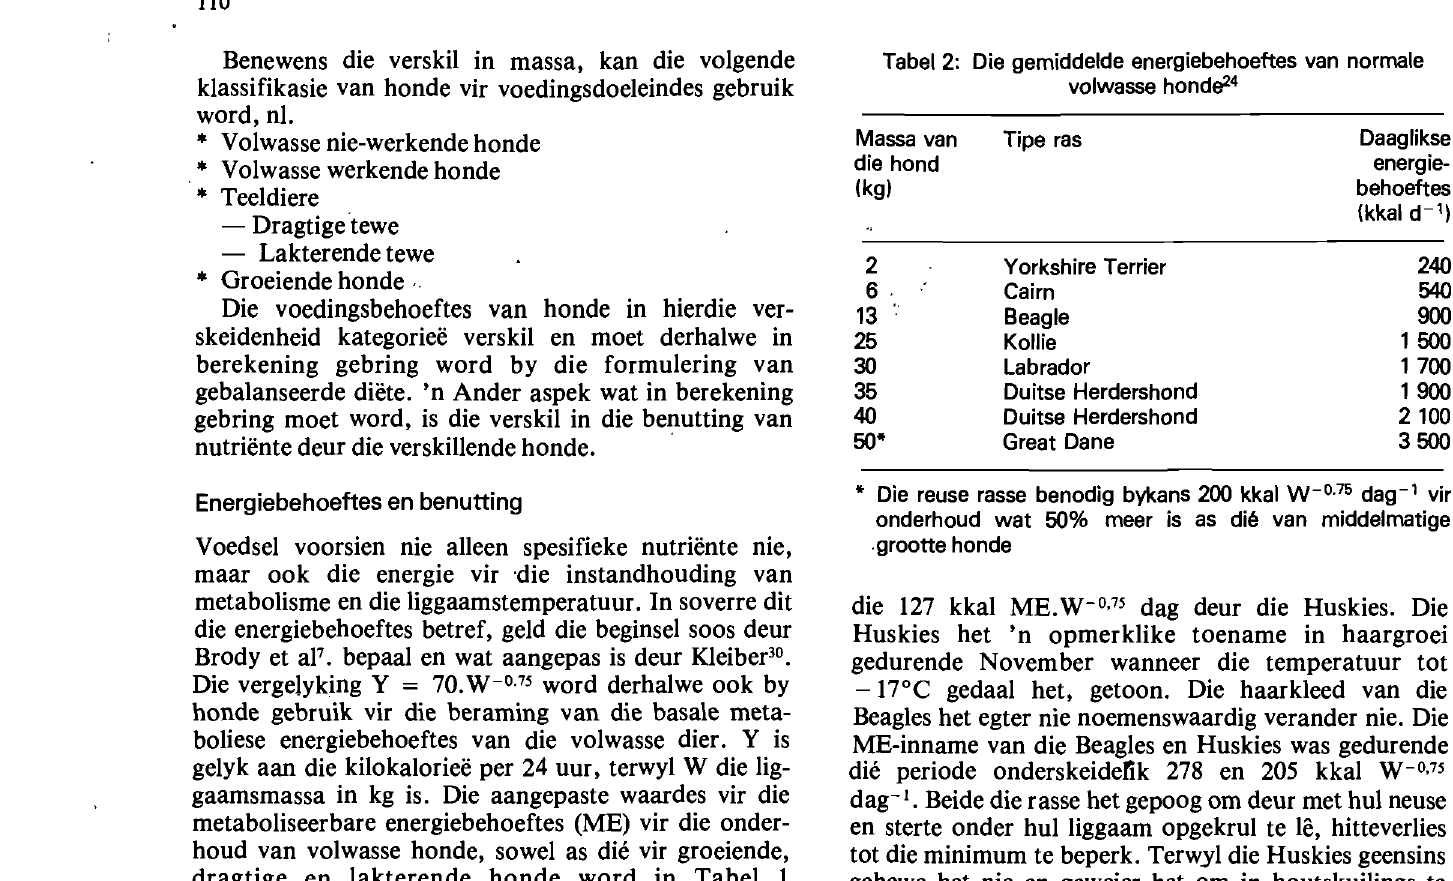
Tabel 1: Skynbare metaboliseerbare energiebehoeftes van honde onder verskillende fisiologiese toestande2 4 Fisiologiese toestand